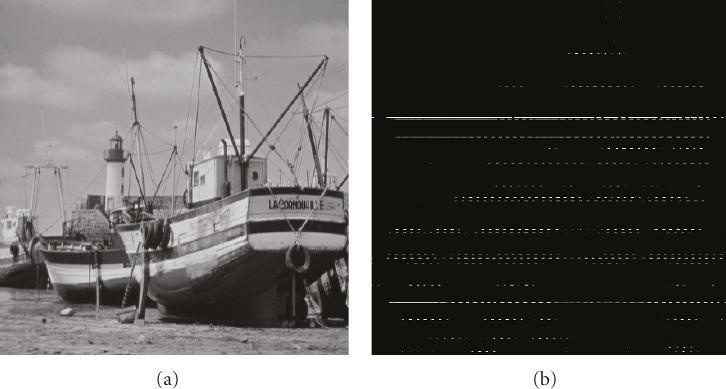
Figure 1: (a) Watermarked Boats Image, (b) 1000 times magnified di ff erence between the original and the watermarked Boats images.